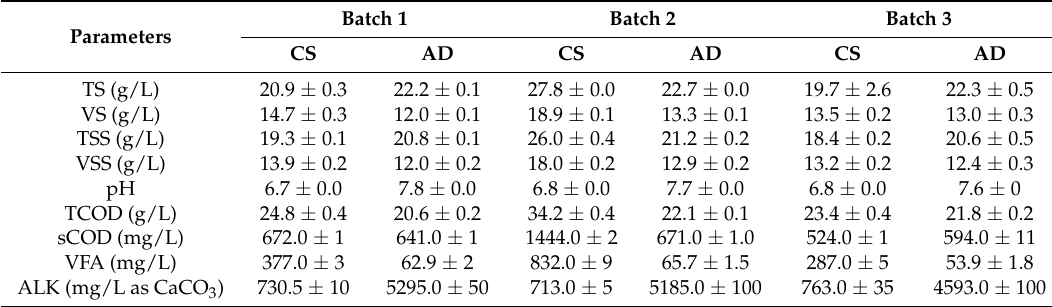
Table 1 . Combined sludge (CS) and inoculum sludge from anaerobic digestion (AD) characteristics for the three batches. TS: total solids, VS: volatile solid, TSS: total suspended solids, VSS: volatile suspended solids, TCOD: total chemical oxygen demand, sCOD: soluble chemical oxygen demand, VFA: volatile fatty acids, ALK: alkalinity.